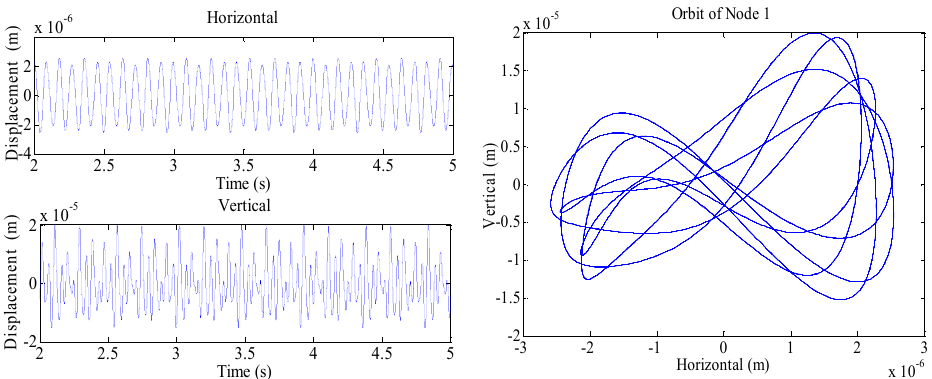
Figure 6. Vibration displacement and the orbit of Bearing 1 (misalignment at Bearing 1).